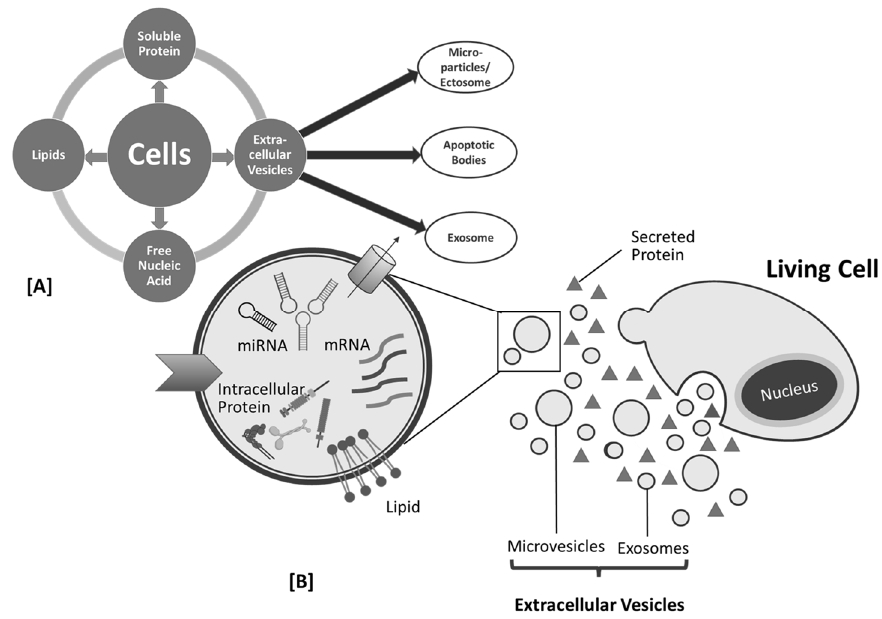
Figure 2. Cell products ( A ) and biogenesis of mesenchymal stem cell (MSC)-derived exosome ( B ).